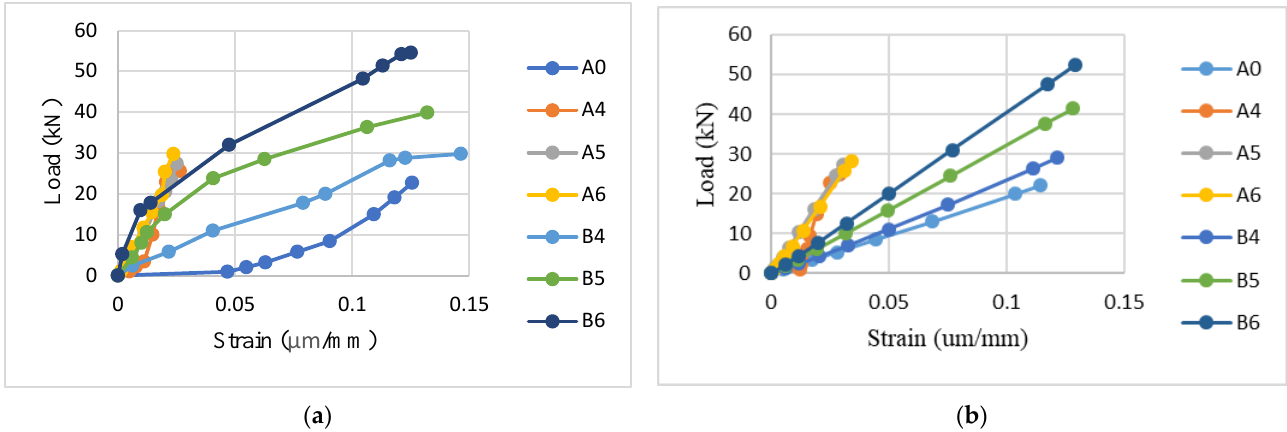
Figure 10. Strain comparison for failure of circular and square pothole patching with asphalt at the interface joint. ( a ): Experimental results. ( b ): Numerical simulation results.